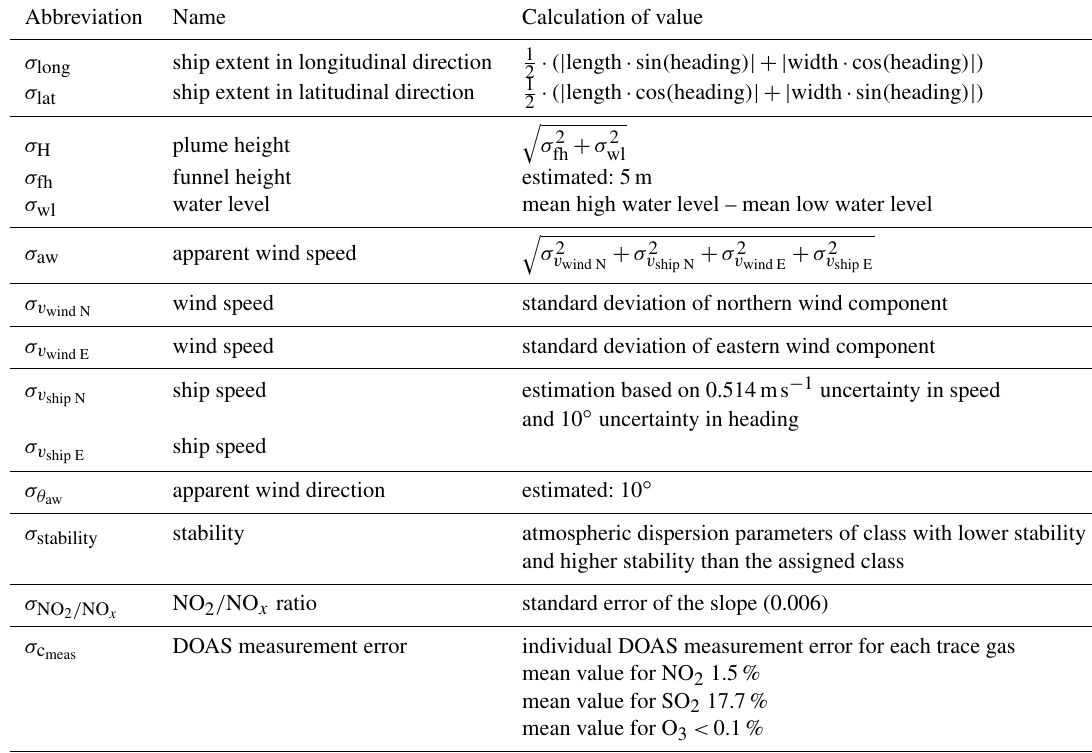
Table 5. Uncertainties of the input parameters used in the Monte Carlo